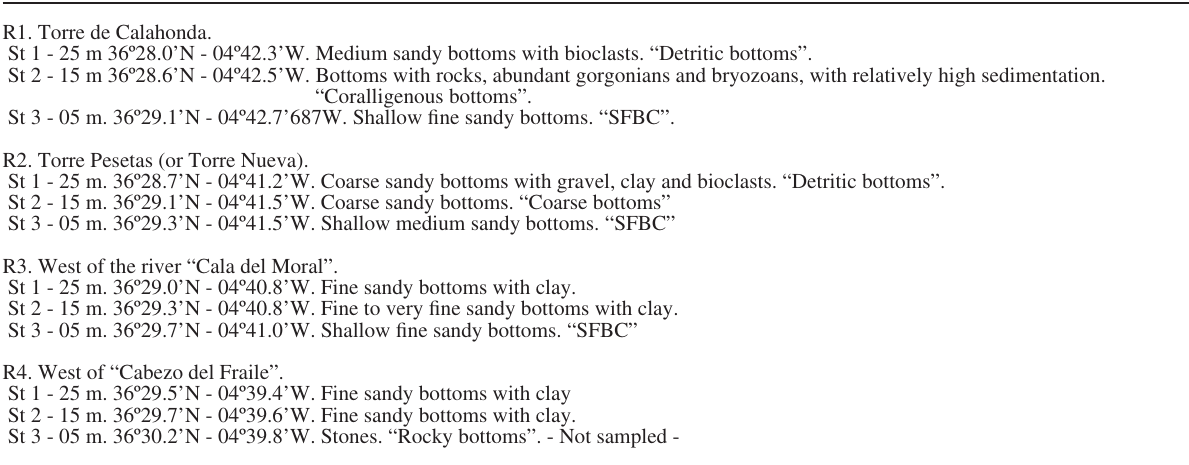
Table 1. – Sampling stations. Locations and some